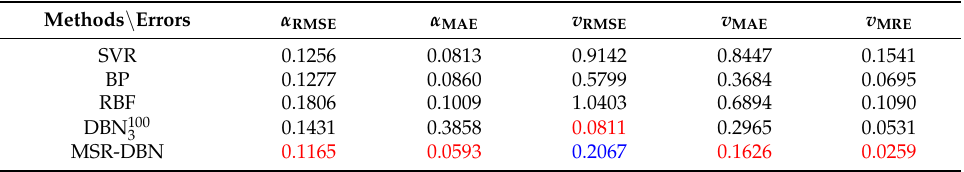
Table 7. Error comparison for front wheel angle and speed based on different models.